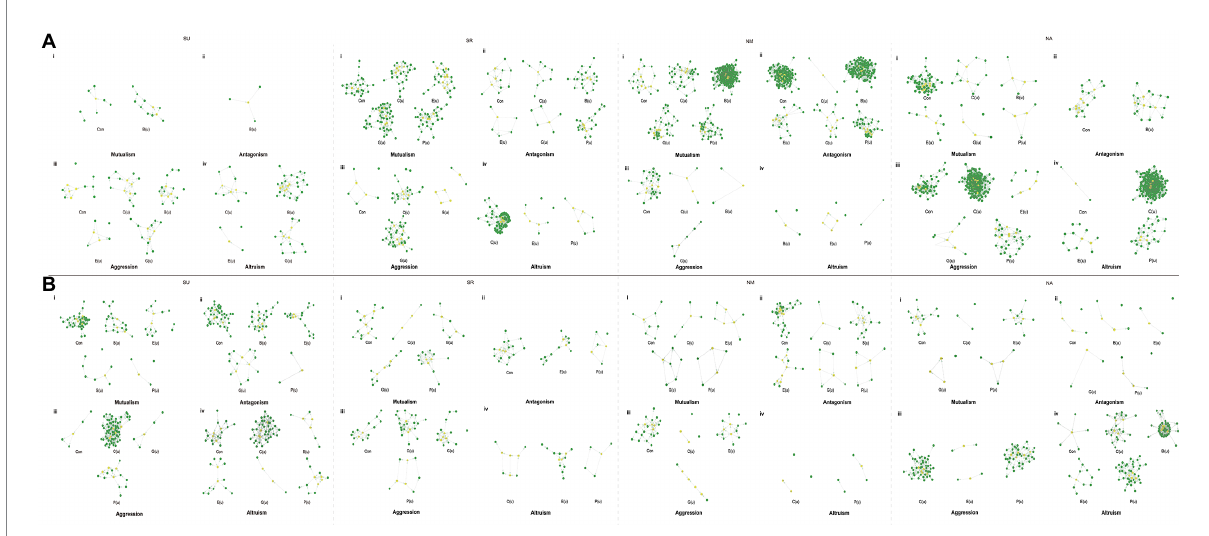
FIGURE 4 Bayesian networks of the significant SNPs from microbial networks. (A) The results of four experiments in 2012, (B) The results of four experiments in 2013. Each node reports a SNP and hub QTLs (SNPs) were colored in yellow. The network characteristic indices were described by connectivity (Con), closeness [C(u)], betweenness [B(u)], eccentricity [E(u)], eigencentrality [G(u)], and PageRank